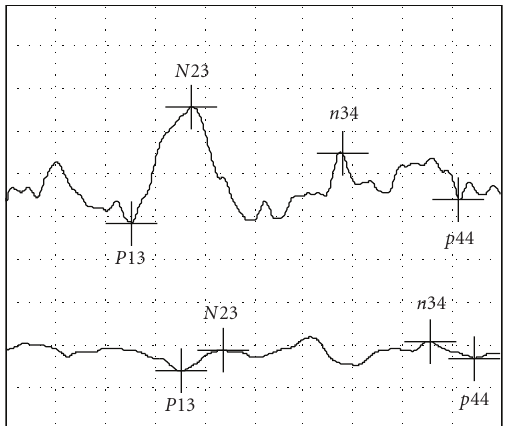
Figure 2: Asymmetrical VEMP recorded from a 5-year-old HI subject. Left side is above (P13 = 11.7 ms) and right side is below. Horizontal square = 5ms and vertical square = 20 μ v.